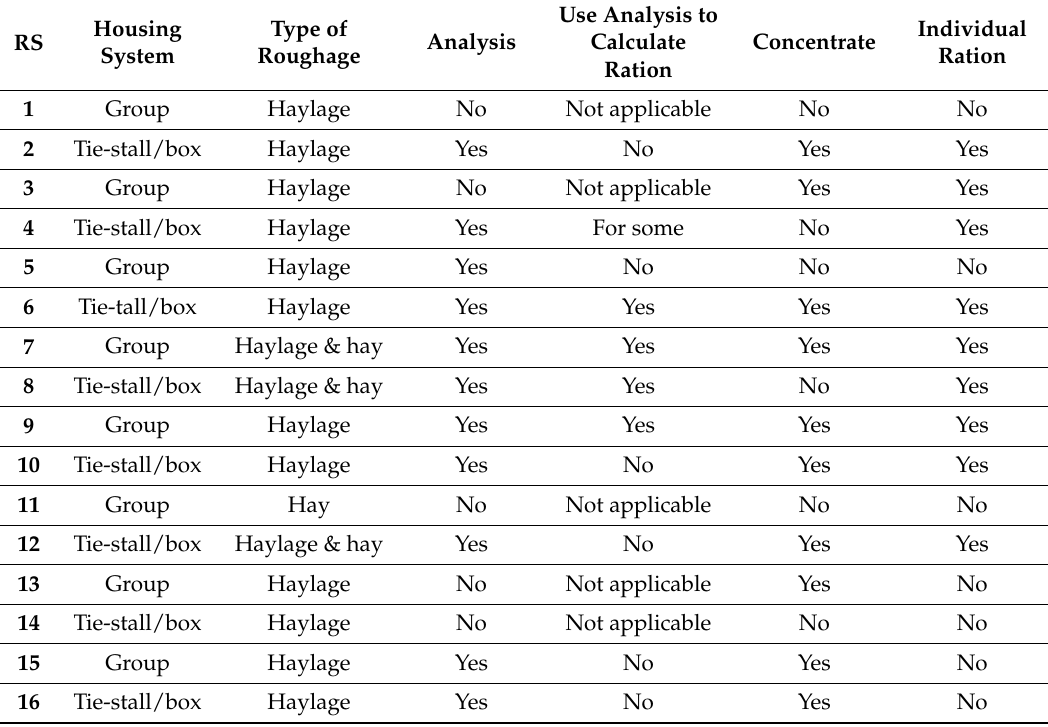
Table 1. Riding school (RS) feeding strategy. All RS that did not use concentrate indicated that they would use it if needed to fulfil the horses’ needs. Four RS (#6, 7, 8, and 9) used a scientifically supported strategy with roughage nutrient and hygienic quality analysis as a basis for calculating the needs of individual